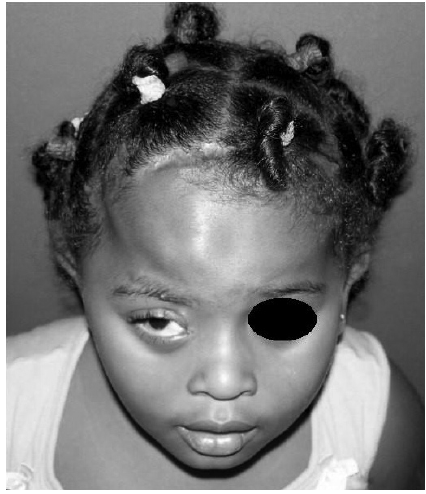
that survive by mosaicism, and the pathogenesis is most neural tube.